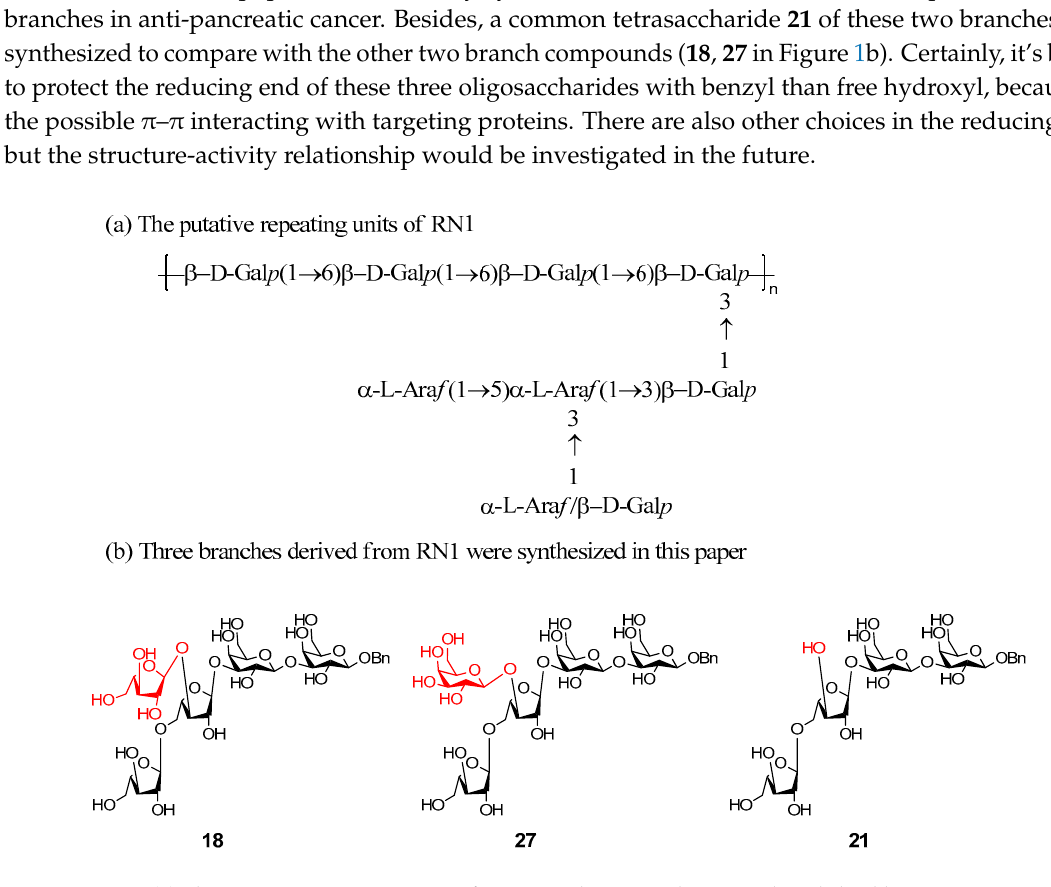
Figure 1. ( a ) The putative repeating units of RN1, a Gal- β -1,6-Gal tetrasaccharide backbone carrying one of the two possible arabinogalactan branches; ( b ) Three branches derived from RN1 were synthesized in this paper. They share same tetrasaccharide 21